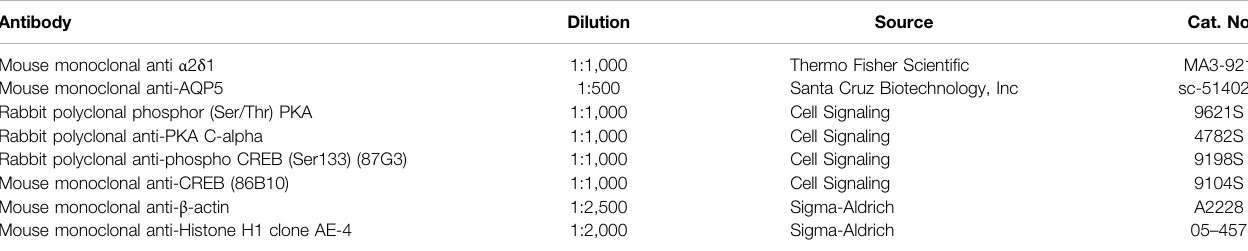
TABLE 1 | List of antibodies used in Western blot.